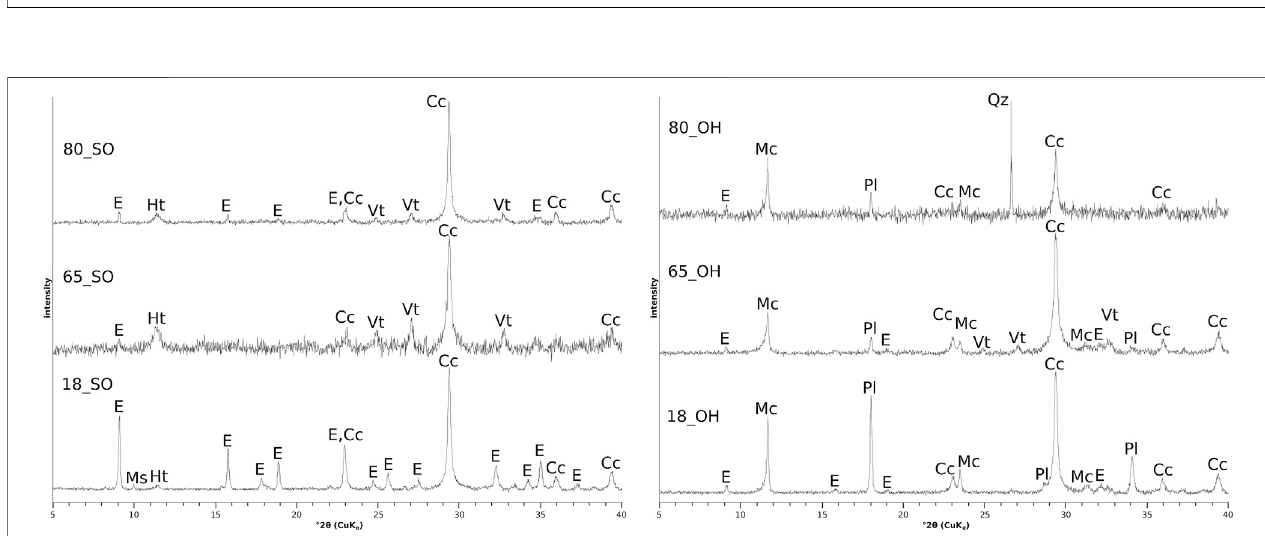
FIGURE 1 | Speci fi c surface area (N 2 -BET) of the surface layer of the hardened binder pastes (left ; ■ : stored in calcium hydroxide solution; ▲ : stored in sodium sulfate solution). An increased speci fi c surface area was observed for the binders with high GGBS contents following storage in sodium sulfate solution (65_SO4 and 80_SO4). Sheet-like structures rich in magnesium, most likely hydrotalcite, were observed by SEM on the surface (right , red arrow).